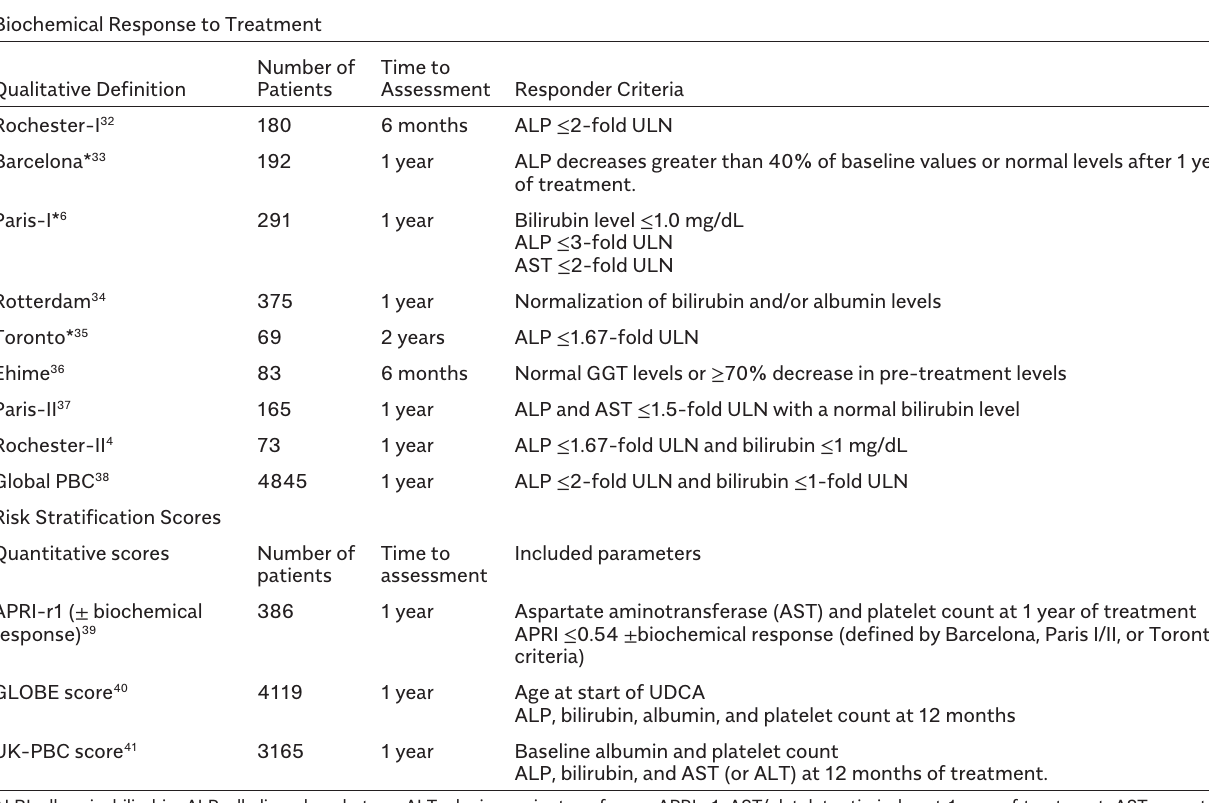
Table 1. Criteria for Predicting Outcomes in Primary Biliary Cholangitis Patients: Biochemical Response to UDCA and Risk Stratification Biochemical Response to Treatment